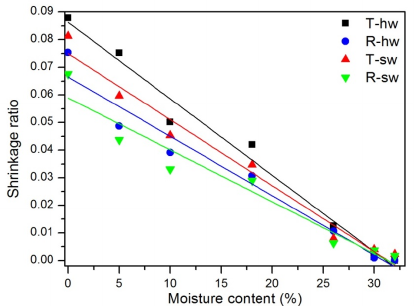
Figure 3. Variation of the shrinkage ratio in heartwood and sapwood of Betula platyphylla between the tangential and radial directions. T ‐ hw indicates tangential heartwood; R ‐ hw, radial heartwood; T ‐ sw, tangential sapwood; R ‐ sw, radial sapwood.